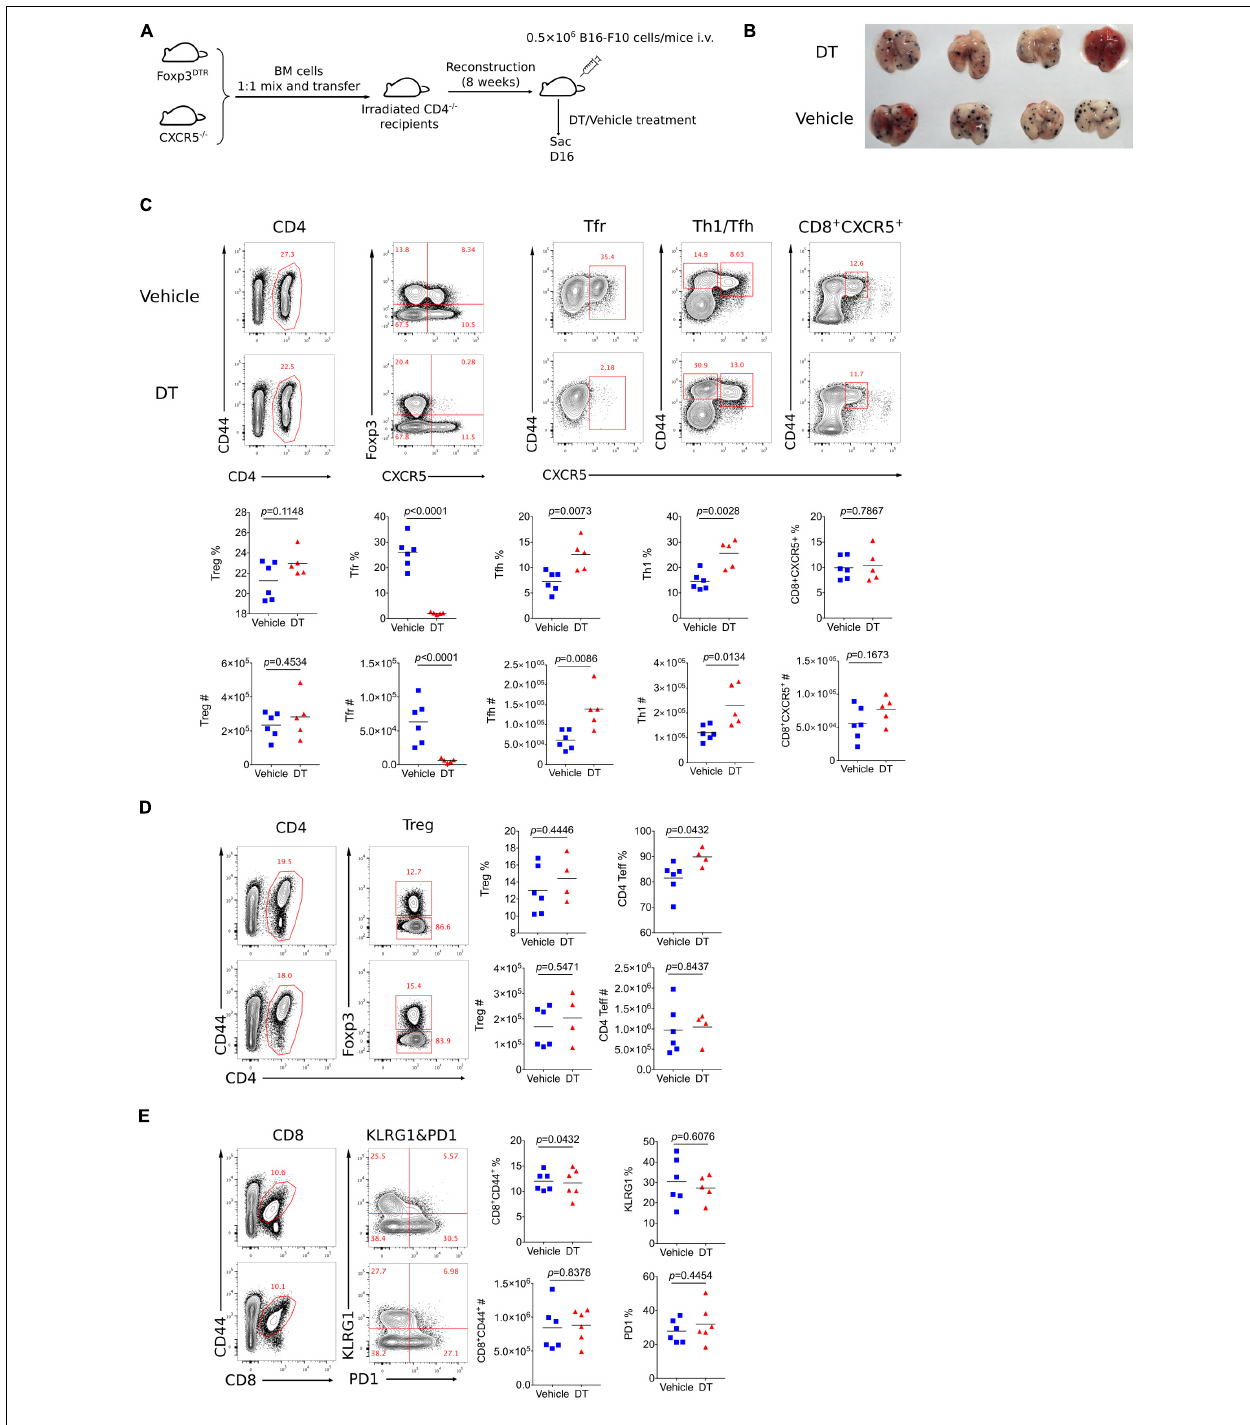
FIGURE 3 | Tfr cells are dispensable for tumor control. (A) Set up of Tfr deficient Bone Marrow Chimera mice. Bone marrow cells were isolated from Foxp3 DTR and Cxcr5 − / − mice were mixed 1:1 and then transferred 8 × 10 6 per mice to irradiated CD4 − / − mice. After reconstruction, mice were inoculated with 5 × 10 5 B16-F10 cells intravenously and were treated with DT or vehicle, then sacrificed at D16 post tumor inoculation. (B) Pictures of lung samples harvested from metastasis model of Tfr deficient mice. (C–E) Flow cytometry analyzing proportion and total number of Treg, Tfr, Tfh, Th1, CD8 + CXCR5 + subpopulation from dLNs (C) and Treg, CD4 + CD44 − (D) , CD8 + T cells (E) from tumor tissue. The data presented are representative of two independent experiments with at least 4 mice per group. # represents the absolute number and % represents the proportion of indicating population. Statistical differences were calculated by unpaired t -test. Center values indicate mean. See also Supplementary Figure 2